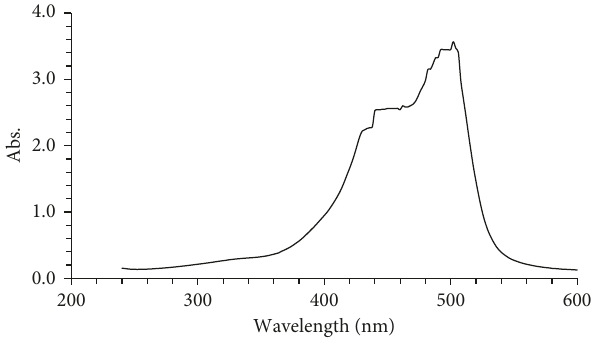
Figure 2: UV-Vis absorption spectrum of